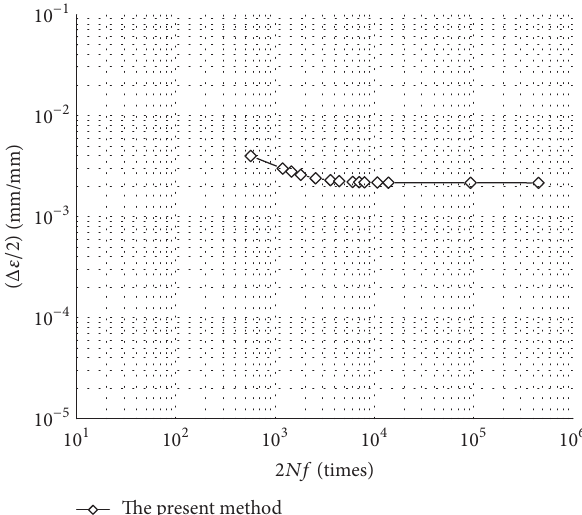
Figure 11: The finite element model of satellite